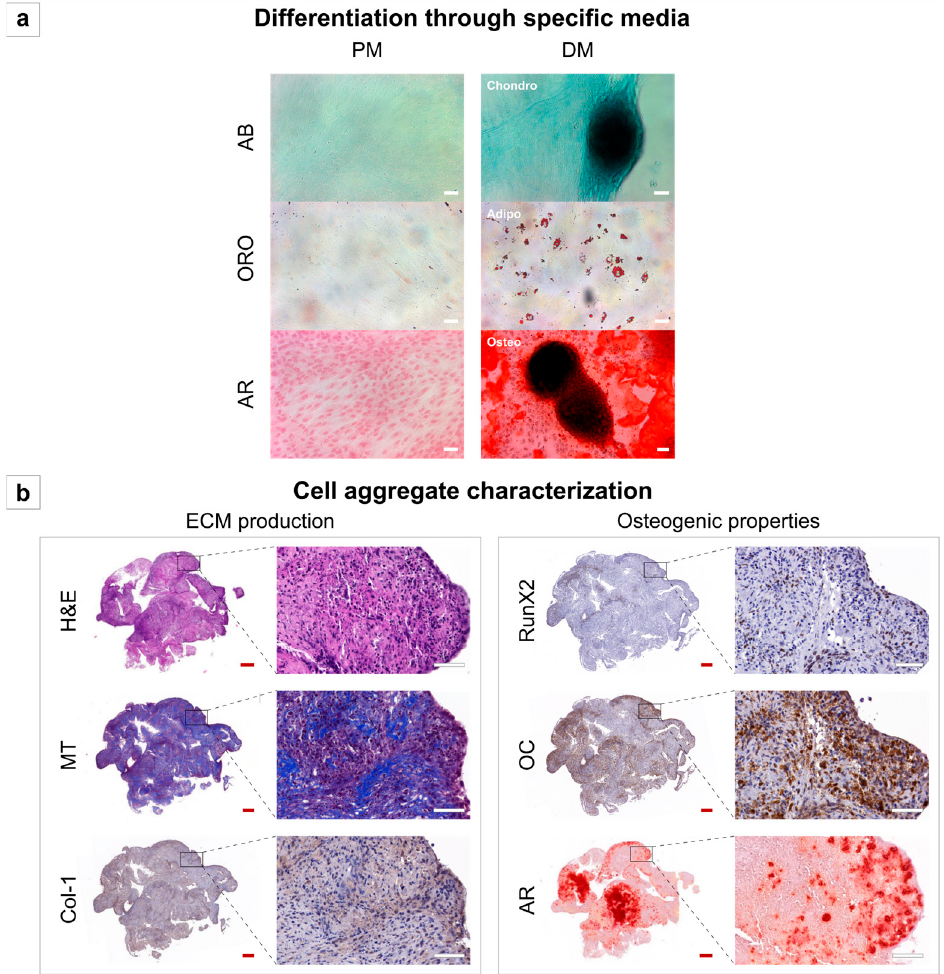
Figure 2. Porcine periosteal mesenchymal stem cell differentiation through chondrogenic, adipogenic, and osteogenic differentiation media ( a ) and cell aggregate characterization after spontaneous forma- tion between 14th and 21st days ( b ). All figures were taken on the 21st day. PM: proliferation medium, DM: differentiation medium, Chondro: chondrogenic differentiation medium, Adipo: adipogenic differentiation medium, Osteo: osteogenic differentiation medium, AB: Alcian blue staining, ORO: Oil red O staining, AR: Alizarin Red staining, H&E: hematoxylin and eosin staining, MT: Masson’s trichrome staining, Col-1: type-1 collagen immunohistochemistry (IHC), and OC: osteocalcin IHC. White scale bars: 50 µ m. Red scale bars: 200 µ